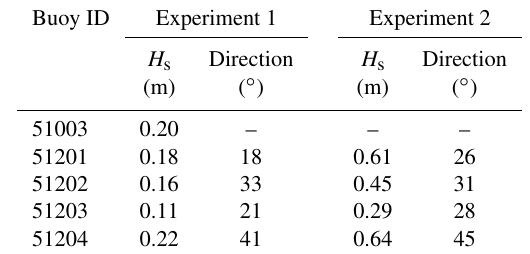
Table 1. Root-mean-squared deviations for the wave significant height ( H s ) and direction, between the model results and the NDBC buoys presented in Fig. 1. All buoys are located in deep water, where the waves do not feel the